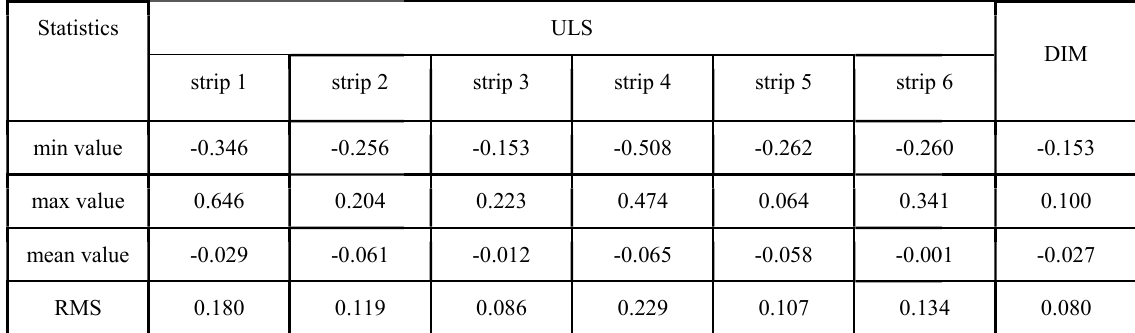
Table 6. Accuracy analysis of the DTM created from different strips of